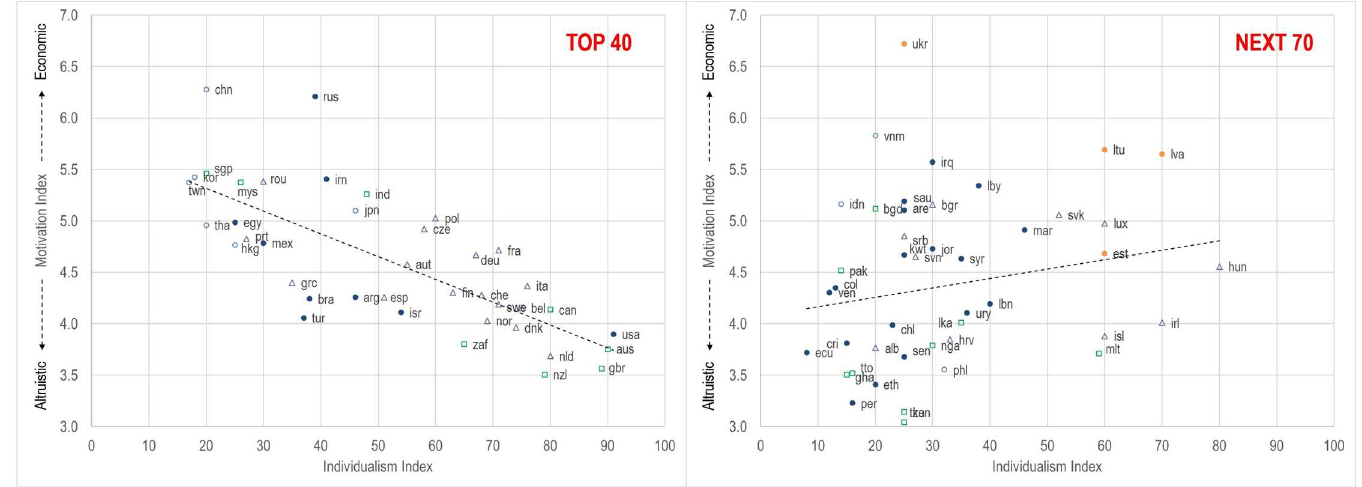
Fig 8. Motivation index as a function of individualism for the top 40 nations and next 70 nations. Legendas in Fig 7.